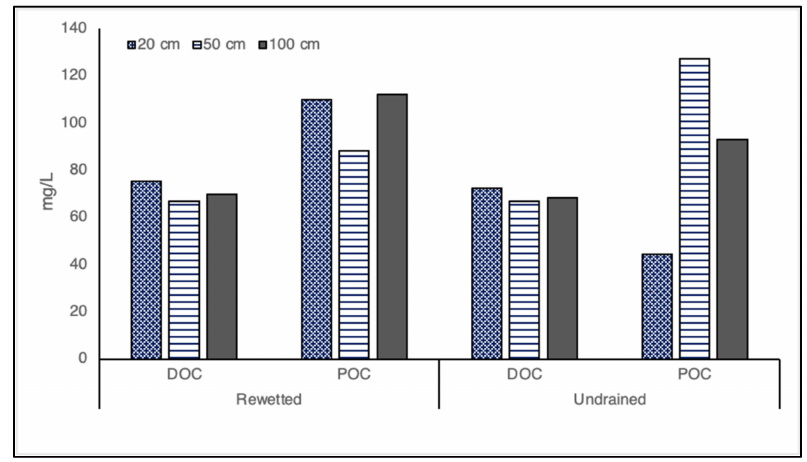
Figure 7. DOC and POC concentrations in rewetted and undrained